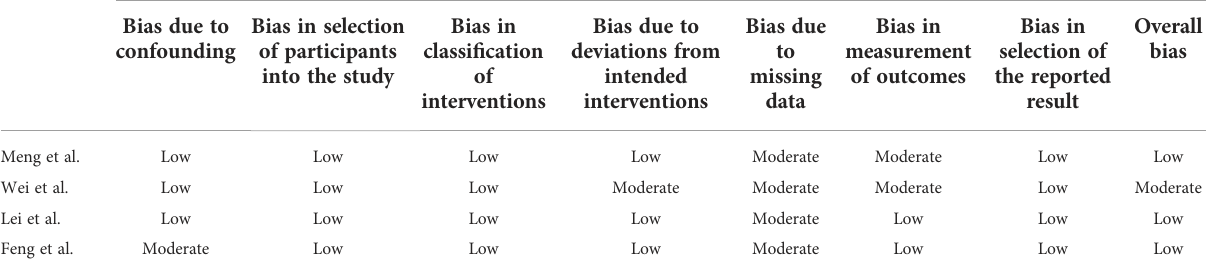
TABLE 1 The Risk of Interventions (ROBINS-I)